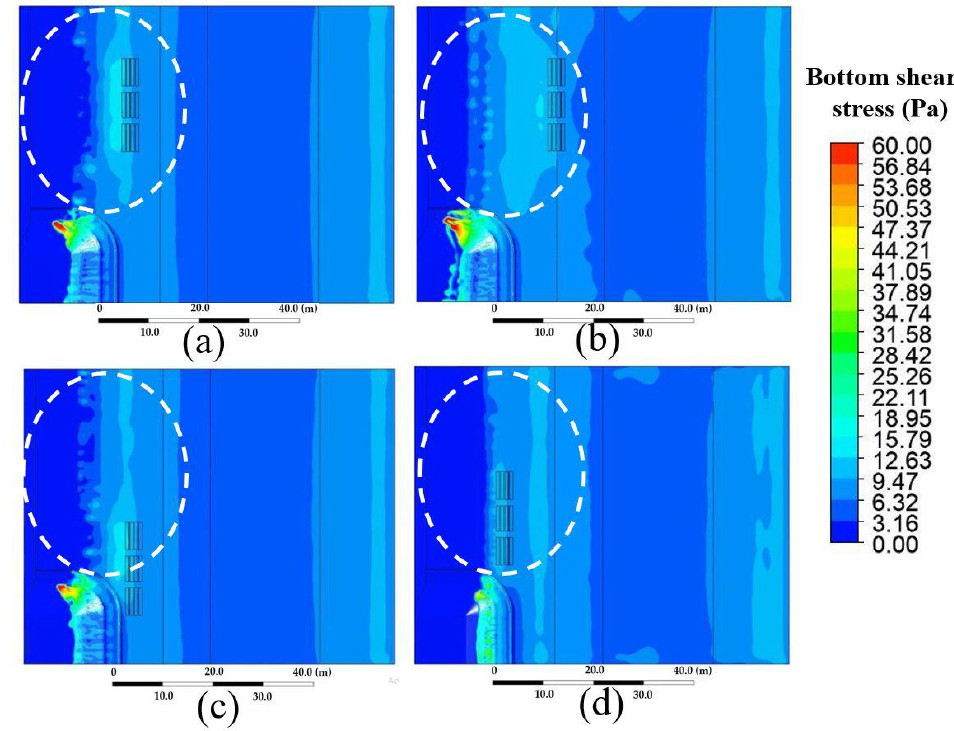
Figure 16. The bottom shear stress of ( a ) P1/15 °, ( b ) P2/15° , ( c ) P3/15° , and ( d ) P4/15